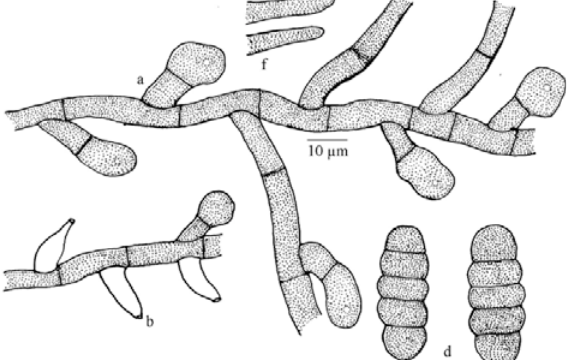
Figure 26. Irenopsis benguetensis a - Appressorium; b - Phialide; d - Ascospores; f - Apical portion of the perithecial